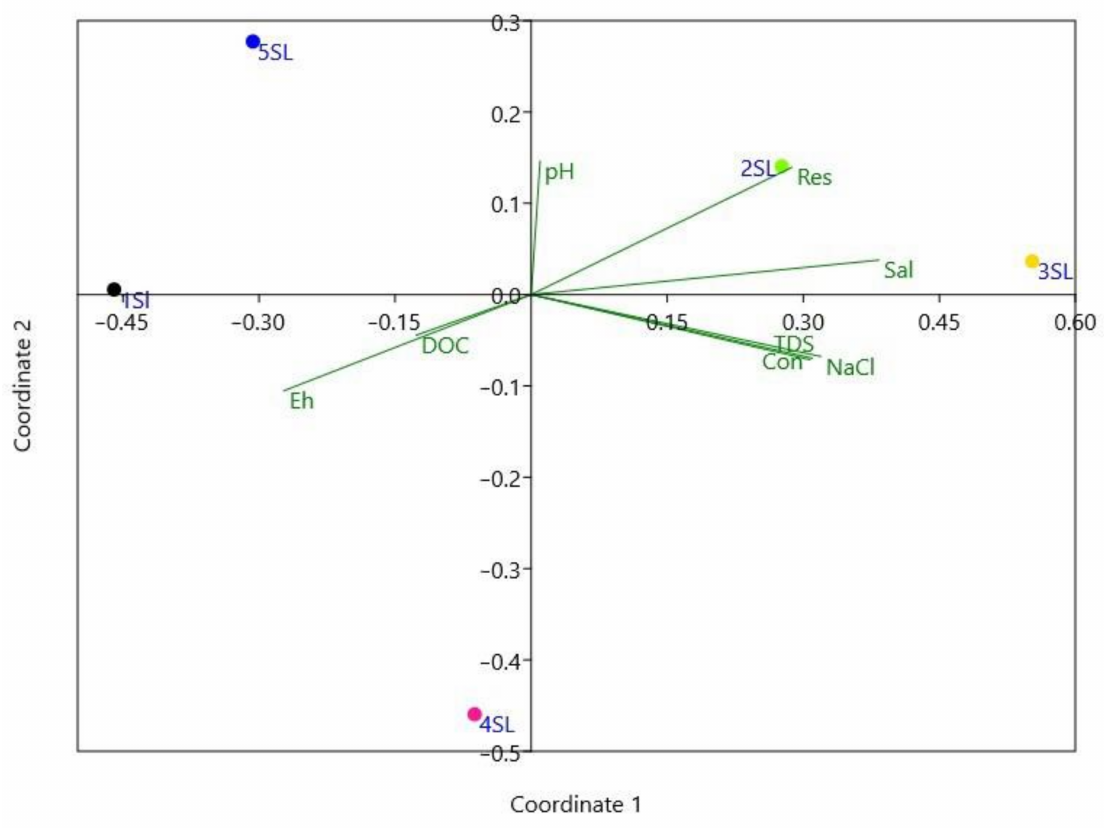
Figure 4. Graphic output of the NMDS ordination displaying localities and significant environmental vectors. (Notes: DOC—dissolved oxygen concentration, Con—conductivity, Res—resistivity, Sal—salinity, TDS—total dissolved solids, Eh—redox potential, 1SL–5SL—sampling